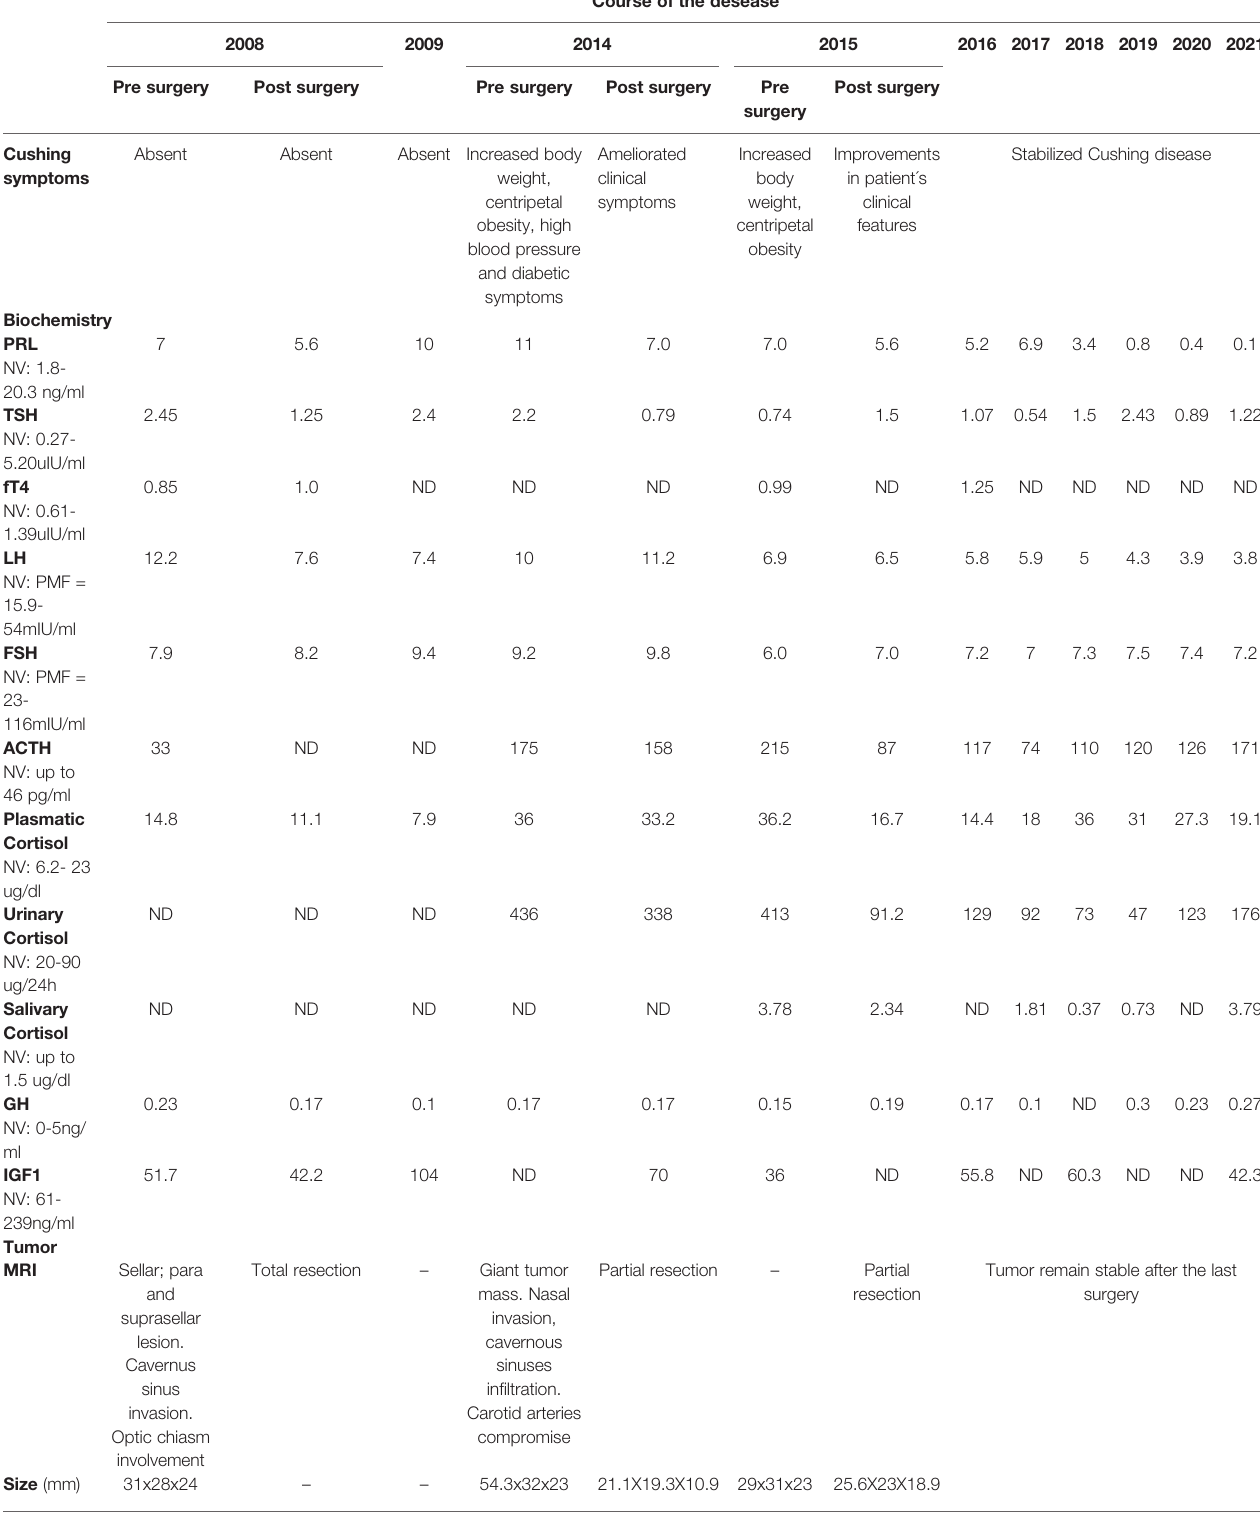
TABLE 1 | Clinical, biochemical, imaging, and pathological fi ndings during the clinical transformation from silent corticotroph tumor to aggressive ACTH-secreting